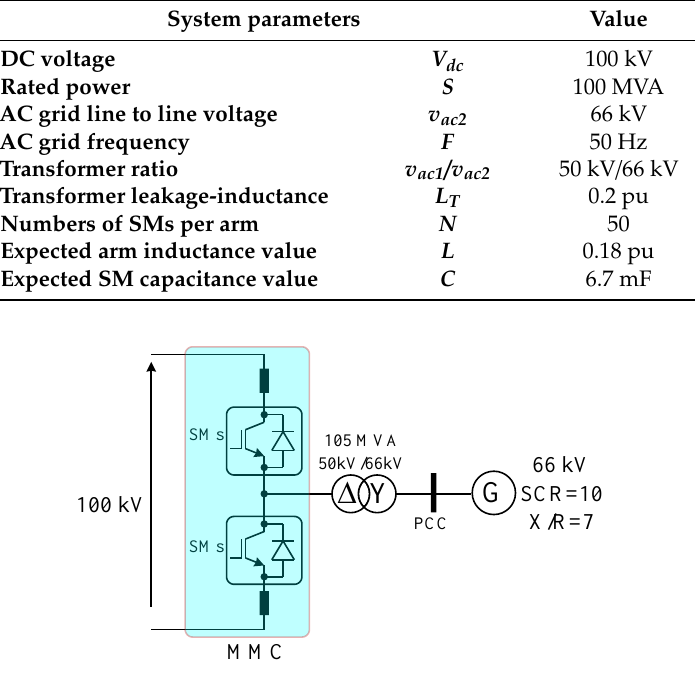
Figure 13. Variation of fundamental frequency dc-link current ripple magnitude (pu) with SM capacitance tolerances T C and arm inductor tolerances T L : ( a ) Scheme-A and ( b ) Scheme-B.